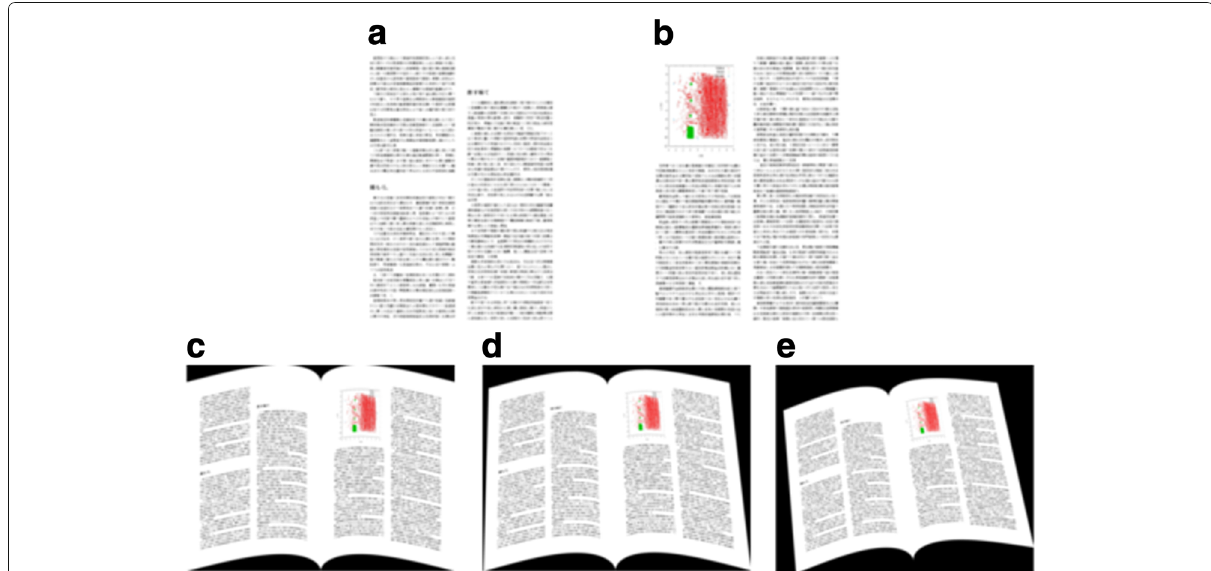
Fig. 3 Computer-generated book image. a Texture drawing (left page). b Texture drawing (right page). c Distortion. d Perspective. e Rotation